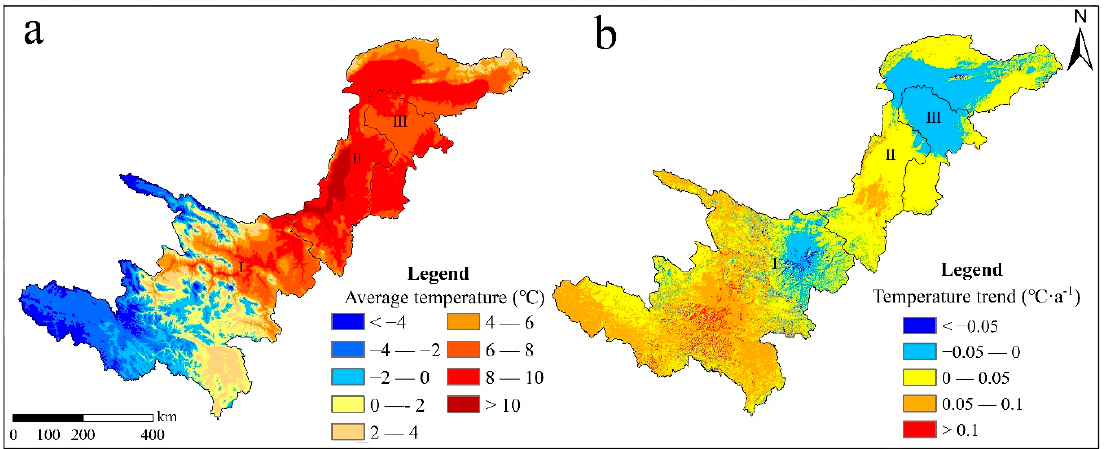
Figure 10. Spatial distributions of the average temperatures ( a ) and temperature trends ( b ) recorded in the study area from 2000 to 2019.